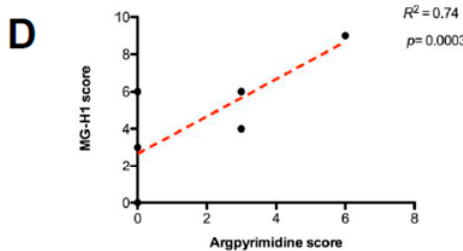
Figure 2. Consistent increase of argpyrimidine adducts in high stage tumors compared with low stage ones suggests a pro-tumor role for dicarbonyl stress. ( A ) Argpyrimidine adducts were examined in a series of 102 primary colorectal cancer patients samples grouped into four clinical stages (T1, T2, T3 and T4) and six normal colorectal tissues. One representative picture is shown for each stage analyzed (100× magnification); ( B ) Immunohistochemical quantification shows argpyrimidine staining evaluation divided into 4 groups (negative, weak, moderate and strong staining) based on the score values. Each dot represents one case and bars represent median. Statistical analysis has been performed using one-way ANOVA followed by Dunn’s Multiple Comparison Test and * p < 0.05, ** p < 0.01, *** p < 0.001. In the right panel, the percentage of negative, weak, moderate and strong argpyrimidine staining is shown for normal tissue and stage 1 to stage 4 tumors; ( C ) An IHC using an antibody against MG-H1 adducts has been performed on 12 CRC samples. IHC staining is shown for representative negative, moderate and strong staining (100× magnification). In accordance with argpyrimidine immunostaining, more MG-H1 adducts have been detected in the highest stage lesions; ( D ) Argpyrimidine and MG-H1 IHC detection showed a significant positive correlation ( R 2 = 0.74, p = 0.0003, Spearman rank correlation test).